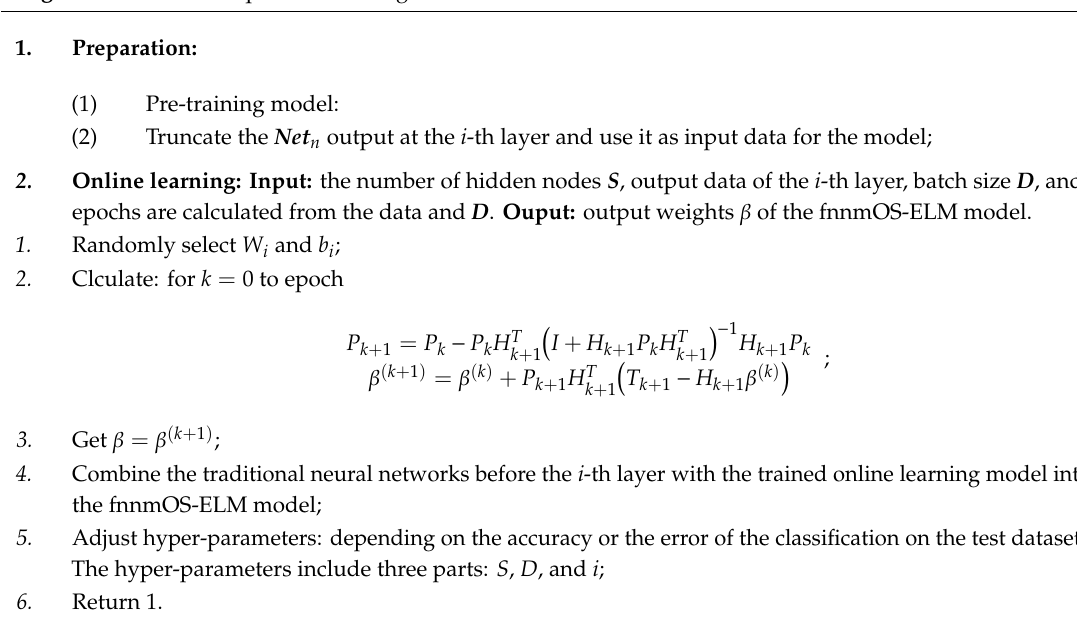
Algorithm 1 Online sequential